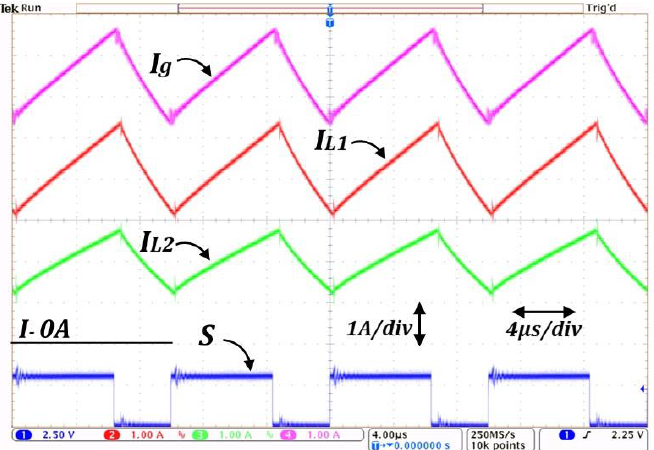
Figure 21. From button to top: the switching function of the transistor s, current through inductors, and input current when V g = 70 V , V o = 200 V , P o = 400 W .